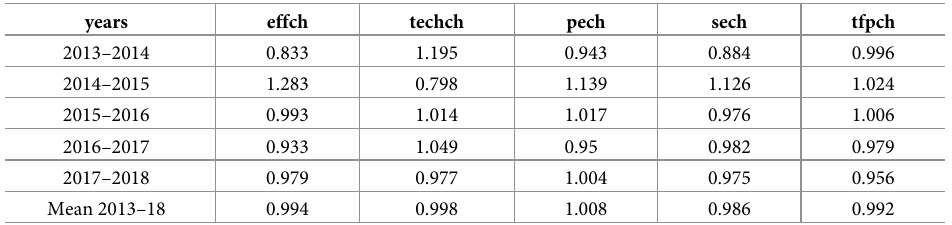
Table 7. Malmquist Productivity Index (MPI) results over